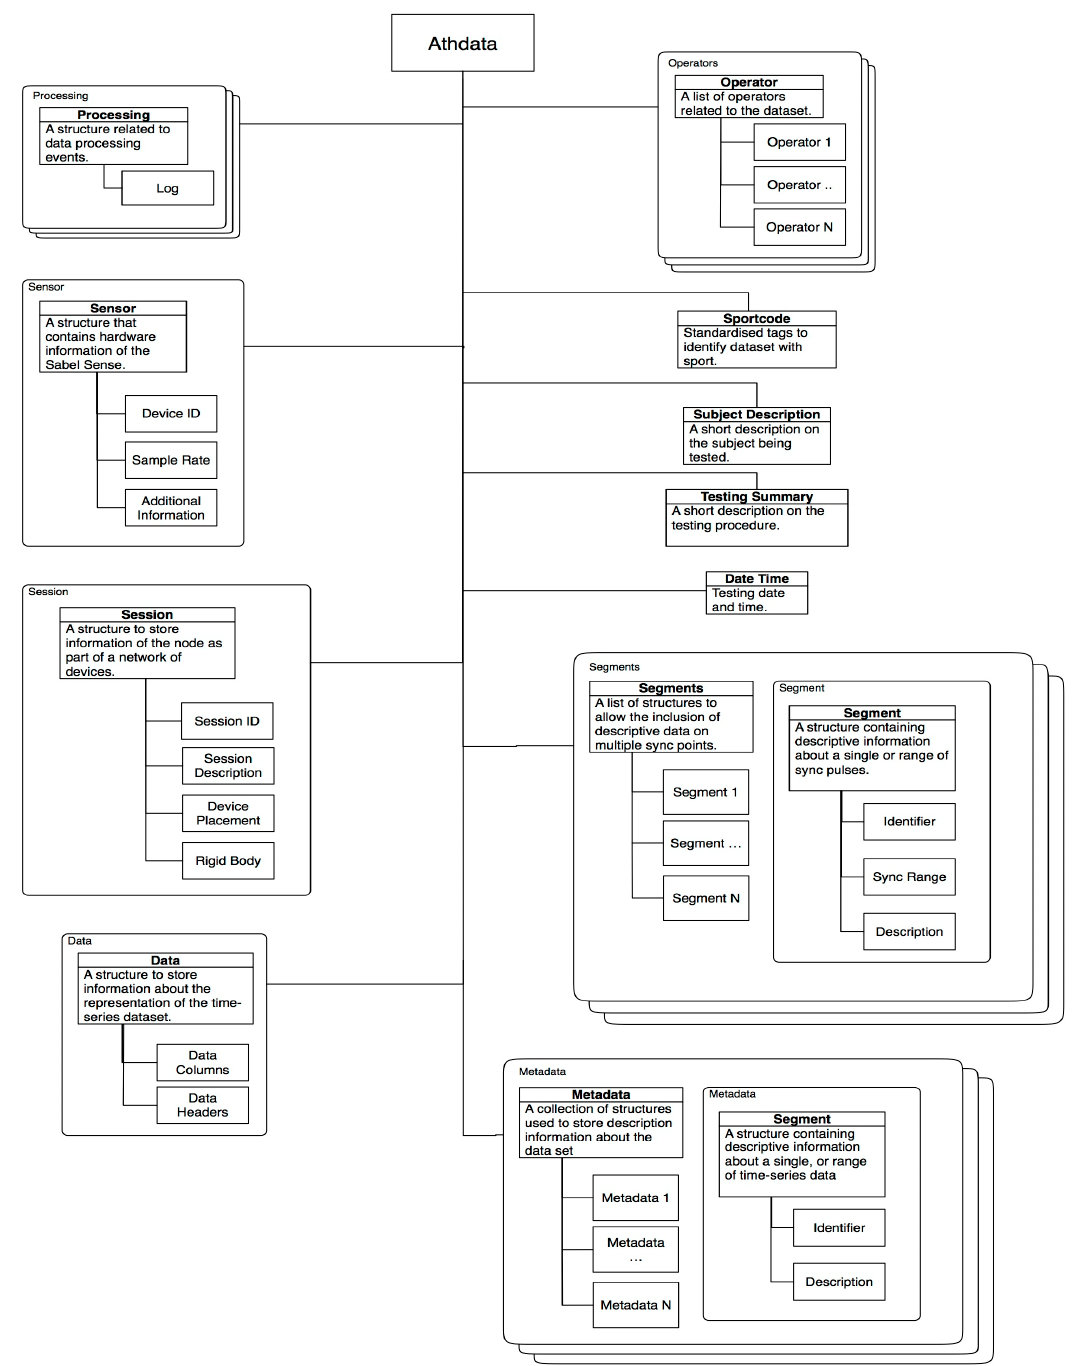
Figure 1. Unified Modelling Language (UML) top-down depiction of the revision for athlete homogeneous wearable sensor data structure.